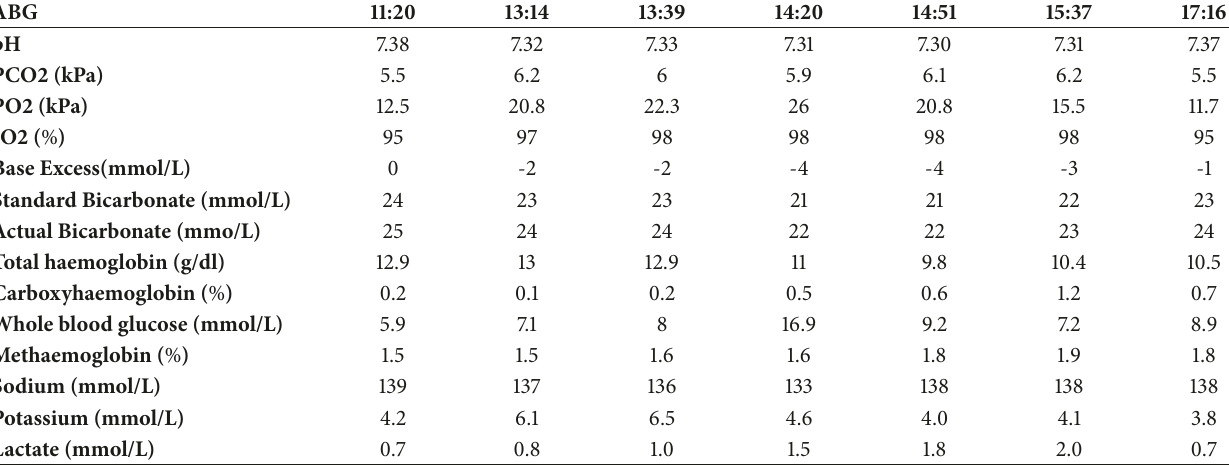
Table 1: Arterial blood gases following induction of anaesthesia and till discharge from the recovery unit.